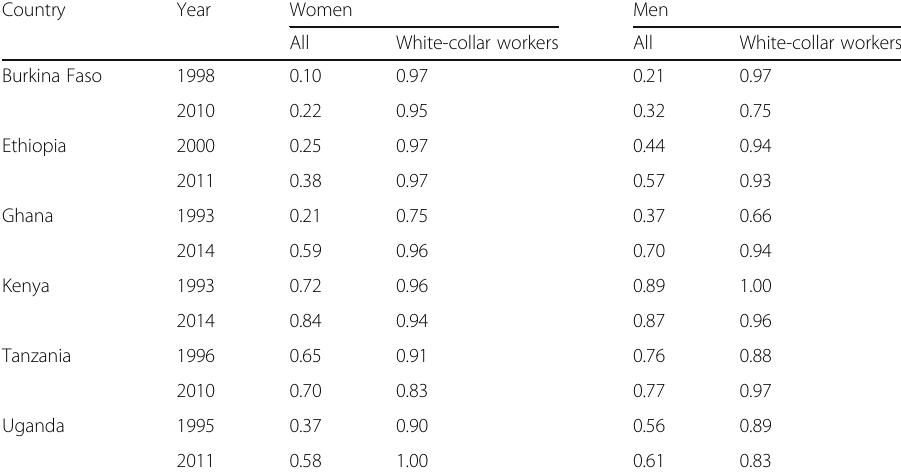
Table 5 Literacy by gender and occupation: proportion of respondents given the top grade in a literacy test Country Year Women Men All White-collar workers All White-collar workers Burkina Faso 1998 0.10 0.97 0.21 0.97 2010 0.22 0.95 0.32 0.75 Ethiopia 2000 0.25 0.97 0.44 0.94 2011 0.38 0.97 0.57 0.93 Ghana 1993 0.21 0.75 0.37 0.66 2014 0.59 0.96 0.70 0.94 Kenya 1993 0.72 0.96 0.89 1.00 2014 0.84 0.94 0.87 0.96 Tanzania 1996 0.65 0.91 0.76 0.88 2010 0.70 0.83 0.77 0.97 Uganda 1995 0.37 0.90 0.56 0.89 2011 0.58 1.00 0.61 0.83 Source: Authors ’ calculations from DHS survey